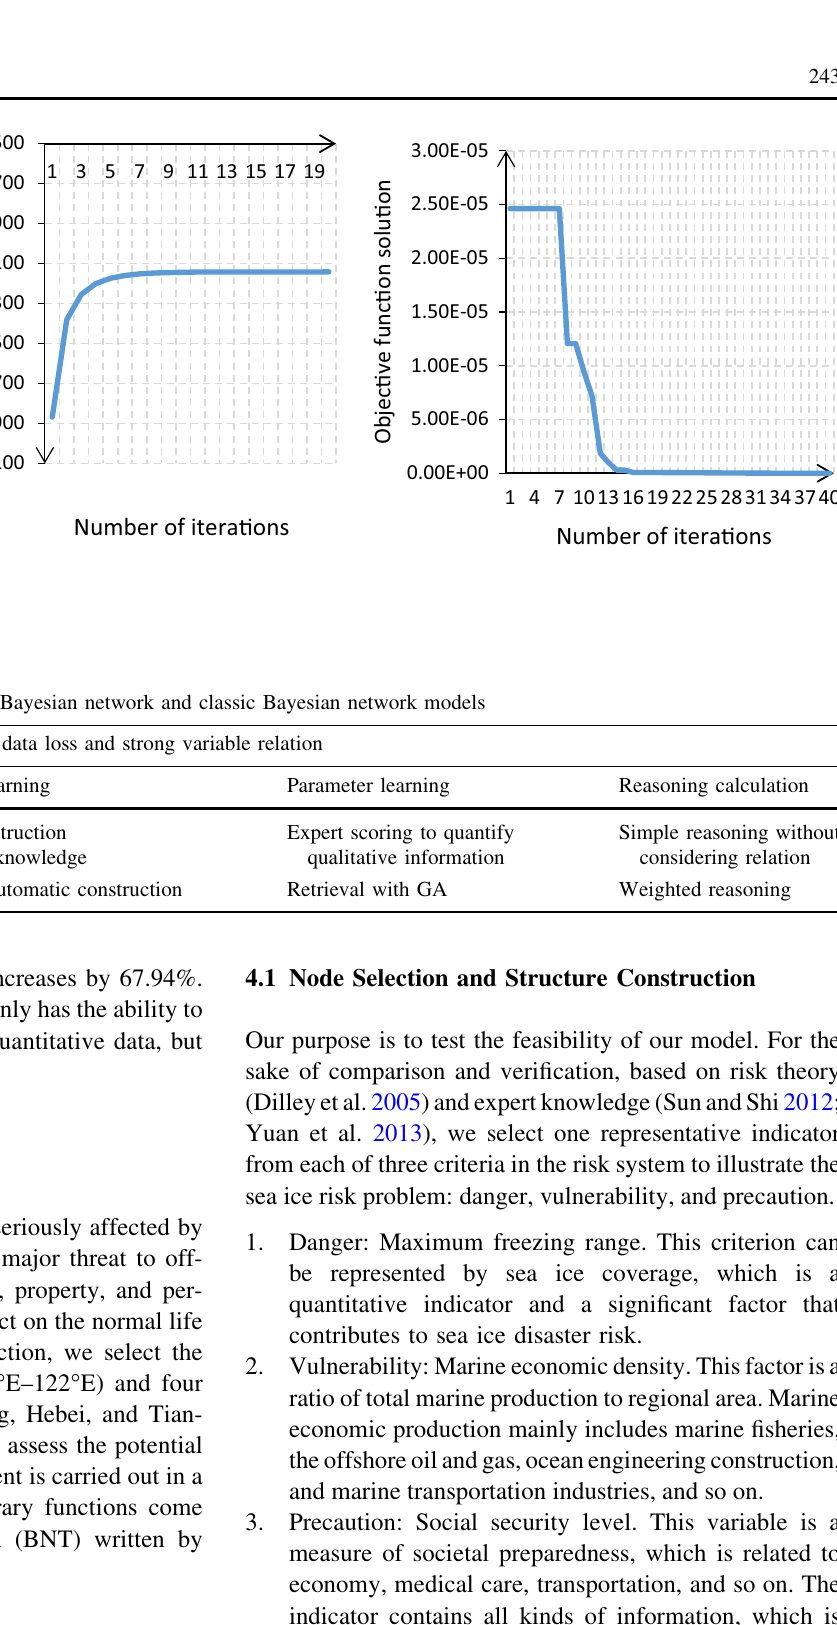
Fig. 4 Convergence curves of different algorithms (left for expectation–maximization (EM) algorithm, right for retrieval algorithm)